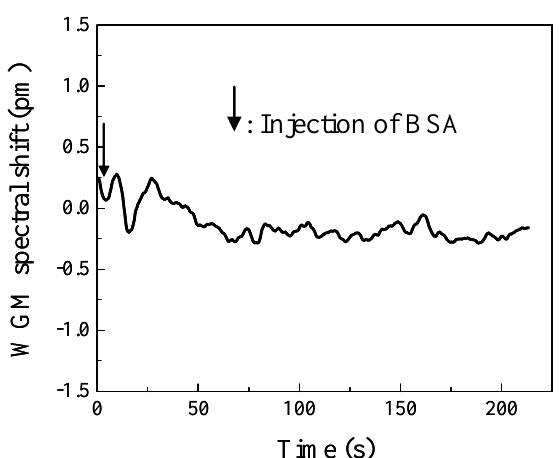
Figure 5. Sensorgram shows that BSA molecules do not bind to the sphere when sphere surface is immobilized with aptamers. Arrow indicates when BSA solution is added. The initial spikes are due to the temperature transient after the BSA injection. BSA concentration = 0.5 mg/mL.